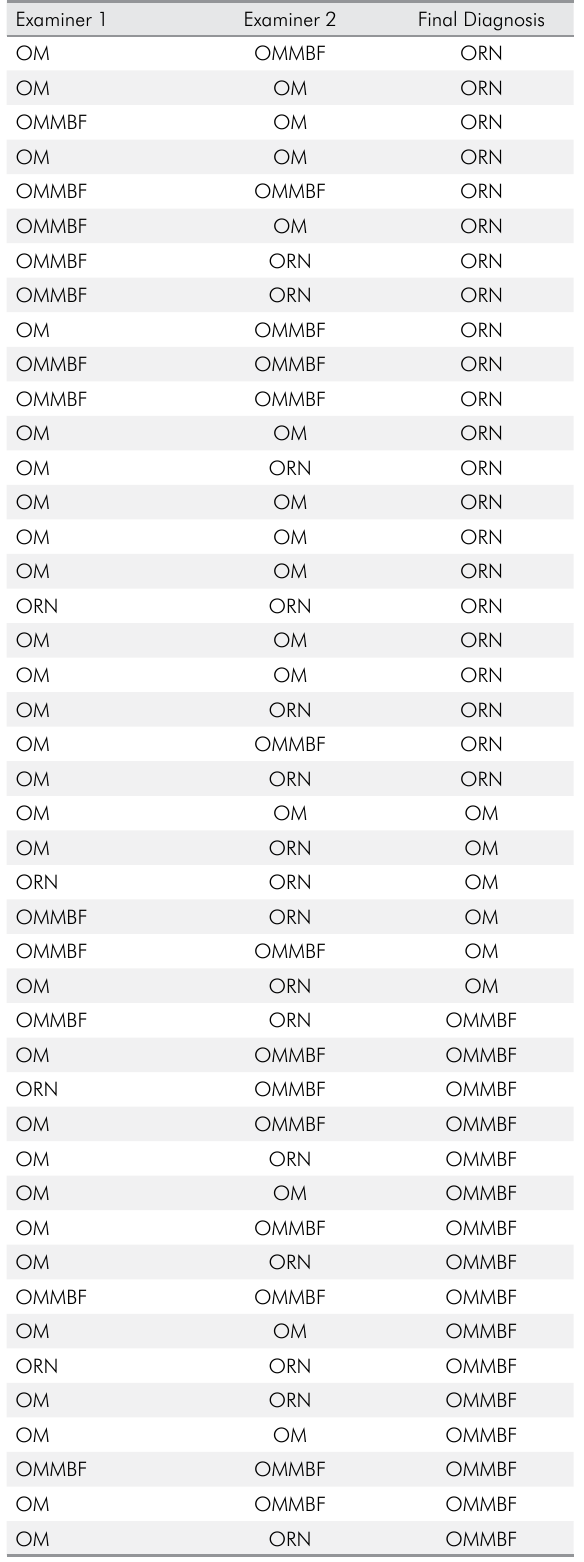
Table 4. Tentative diagnosis of each examiner per sample, indicating lack of consistency between them